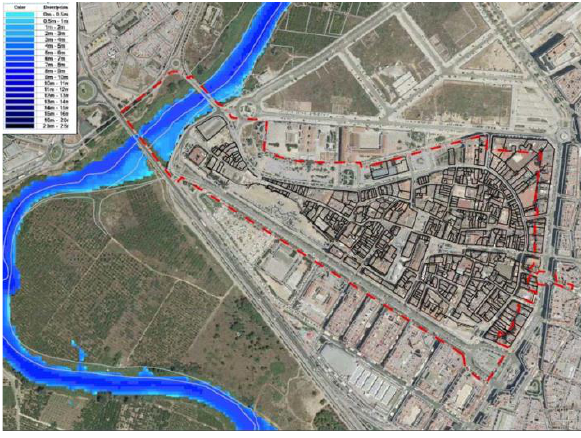
Figure 5. Draught levels. Return period of 10 years. (SNCZI)